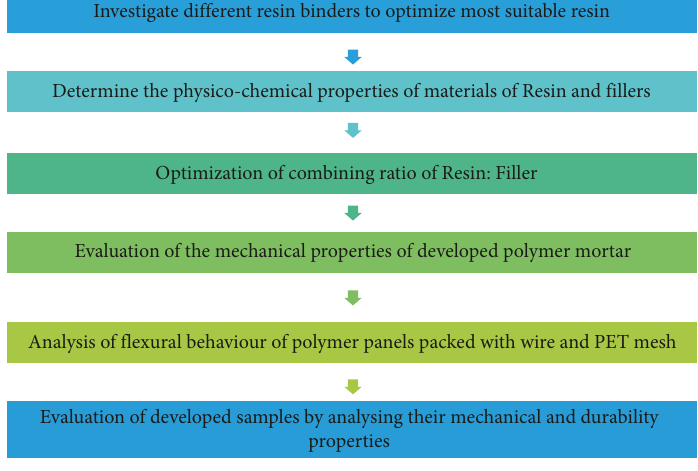
Figure 9: Development approach of polymer based panels.